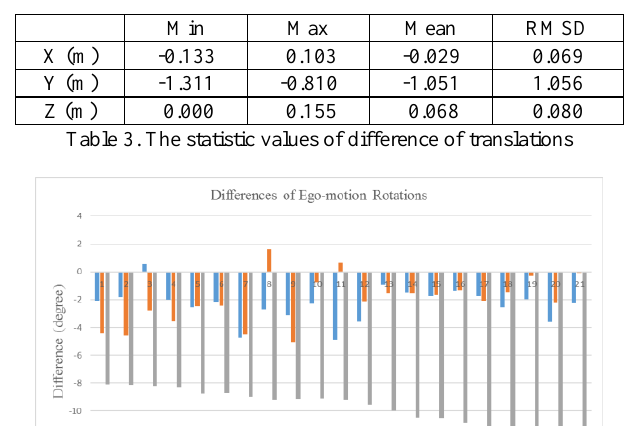
Figure. 6 Difference of translations between ego-motion and ground truth